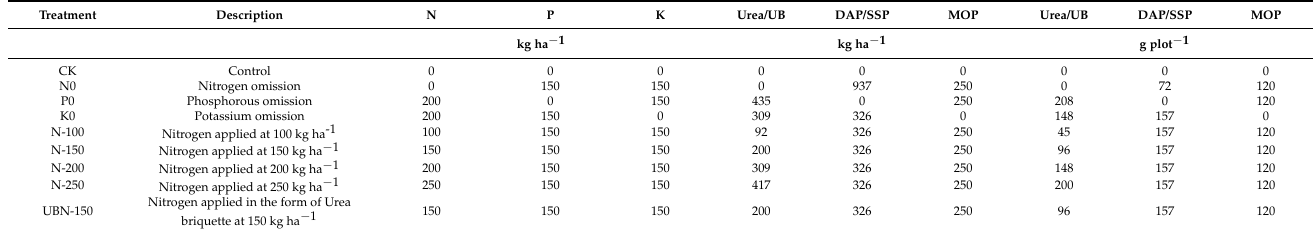
Table 2. Description of the